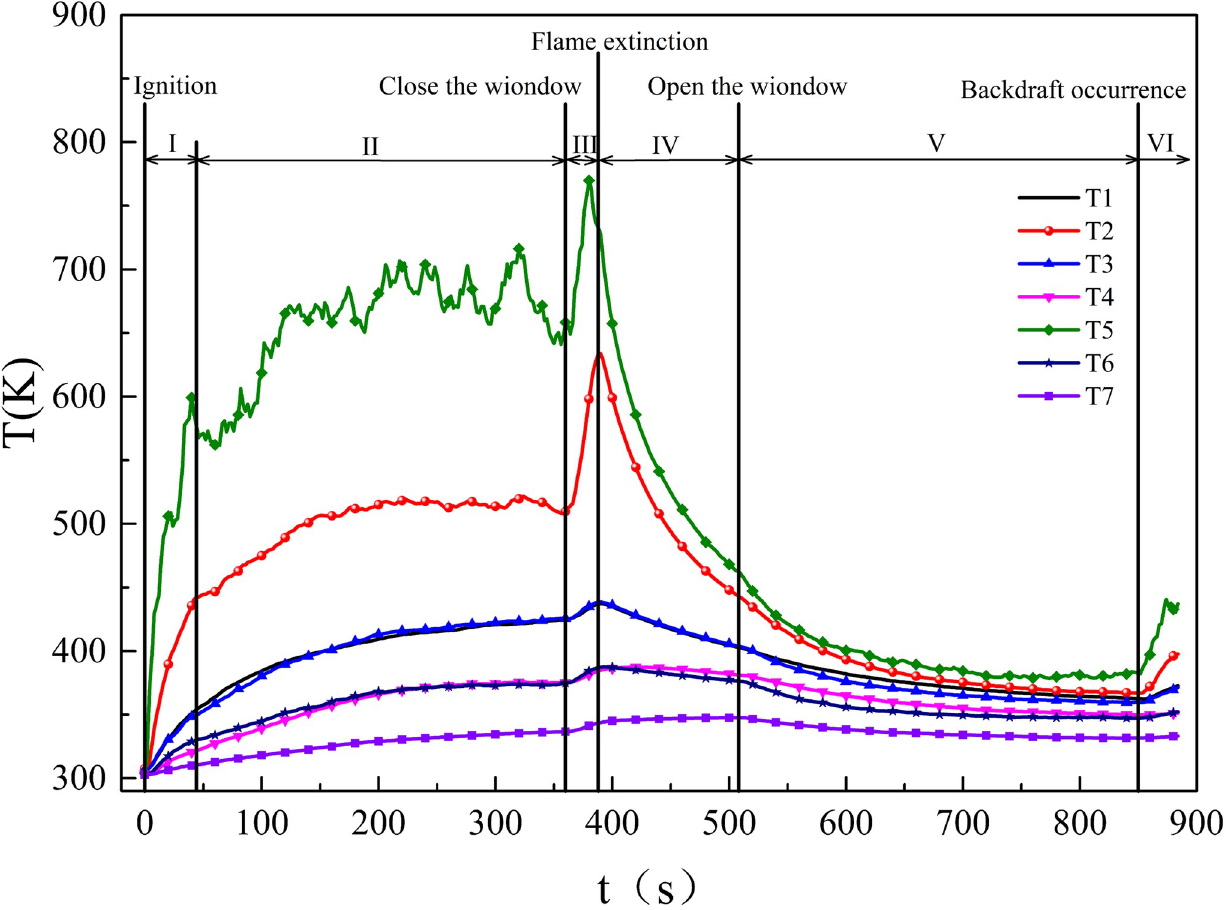
Fig 4. Temperature curves of the Test 8: (I) alcohol burning; (II) woodblocks steadily burning; (III) woodblocks transition from complete burning to incomplete burning; (IV) wood blocks smoldering; (V) gas exchange and smoldering intensely; (VI) wood blocks steadily burning again.